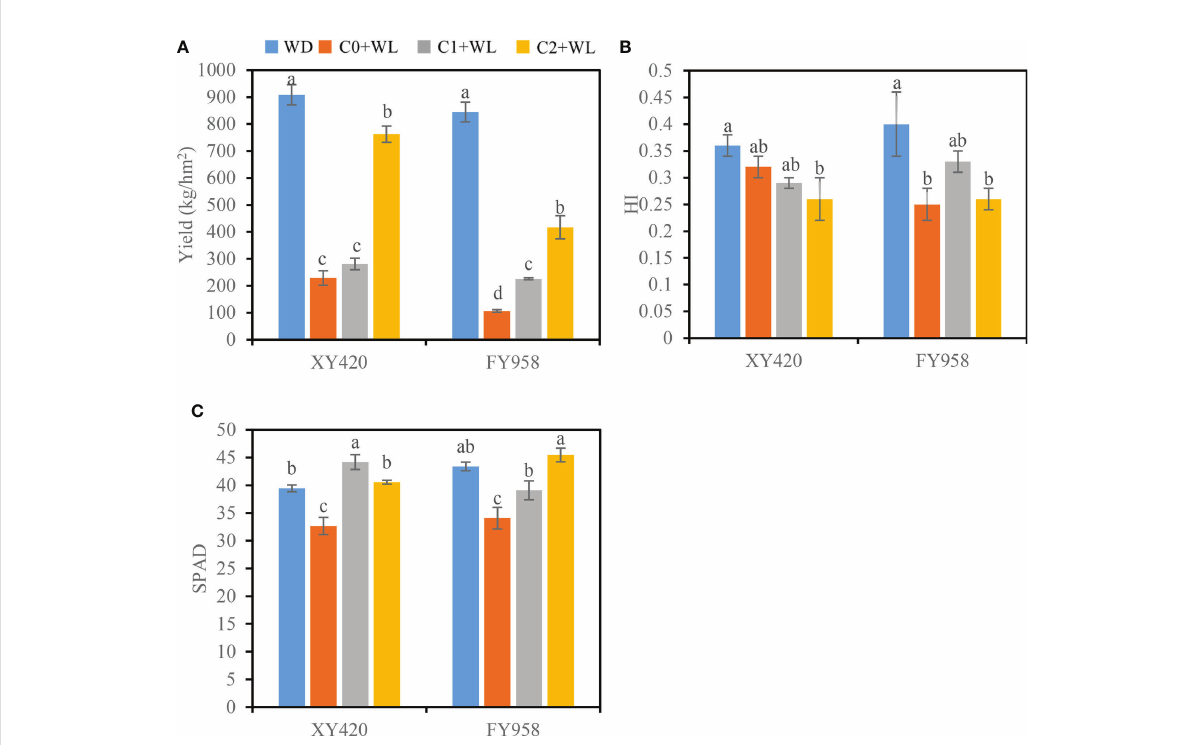
FIGURE 2 Effects of CaO 2 on the yield of rape and harvest index (HI) at the harvest stage and leaf SPAD values under waterlogging conditions. (A) , yield. (B) , HI, harvest index; (C) , SPAD, SPAD values. Error bars represent standard errors. Different letters above bars indicate signi fi cant differences between planting patterns at P < 0.05. WD, well-draining, C0+WL, no CaO 2 and waterlogging, C1+WL, 594 kg hm -2 of CaO 2 in the form of base fertilizer and waterlogging, and C2+WL as in treatment C1+WL but a supply of 864 kg hm -2